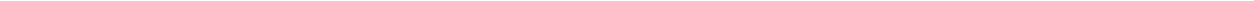
Fig. 5 Tumor-induced muscle wasting depends on tumor cell-expressed Hsp70 and Hsp90. a Conditioned medium of Hsp70- and Hsp90-de fi cient LLC cells do not induce myotube catabolism. C2C12 myotubes were treated with LCM from LLC cells transfected with random or Hsp70/Hsp90-speci fi c siRNA as indicated. Catabolic response was evaluated as described in Fig. 2. Data ( n = 3) were analyzed by analysis of variance (ANOVA). * denotes a difference ( P < 0.05). b Serum Hsp70 and Hsp90 levels in mice bearing Hsp70- and Hsp90-de fi cient LLC tumor remain unchanged. LLC cells were transduced with lentivirus encoding Hsp70 and Hsp90-speci fi c shRNA, or lentivirus carrying empty vector as control. Mice were implanted with Hsp70&90-de fi cient or control LLC cells. On day 21 serum levels of Hsp70 and Hsp90 were analyzed after Brij98 treatment. Data ( n = 6) were analyzed by ANOVA. * denotes a difference ( P < 0.05). c Hsp70&90-de fi cient LLC tumor does not induce muscle catabolism in mice. TA of mice derived from b was analyzed by western blotting for markers of catabolic pathways. Data ( n = 6) were analyzed by ANOVA. * denotes a difference ( P < 0.05). d Hsp70&90-de fi cient LLC tumor do not cause muscle wasting in mice. Mice derived from b were further analyzed for muscle wasting. Scale bar , 100 μ m. Data ( n = 6) were analyzed by ANOVA or χ 2 analysis (for CSA). * denotes a difference ( P <